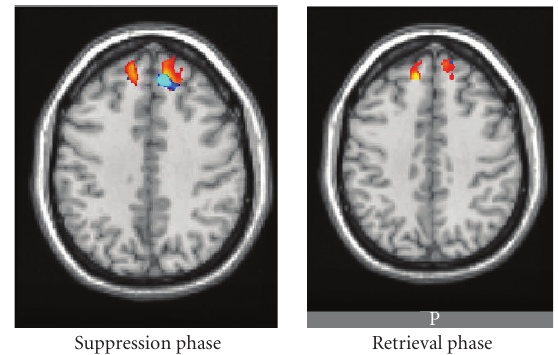
Figure 1: DLPFC activation during the memory suppression and retrieval phases in patients (blue) and healthy controls (red)